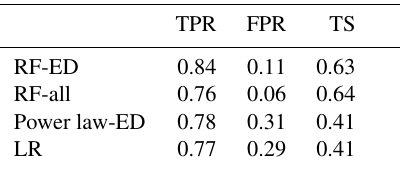
Table 7. Model performance according to the thresholds based on maximization of TS.